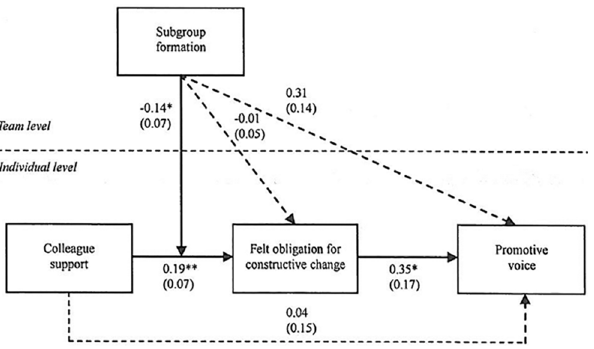
Fig 2. Path coefficients from the selected model. For reasons of brevity, we do not present the effects of team size and procedural justice climate on subgroup formation and individual-level variables or the effects of individual-level gender, age, team tenure, LMX and team identification on felt obligation for constructive change and promotive voice. Interested readers may contact the corresponding author for estimates of these effects. ** p < .01, * p <